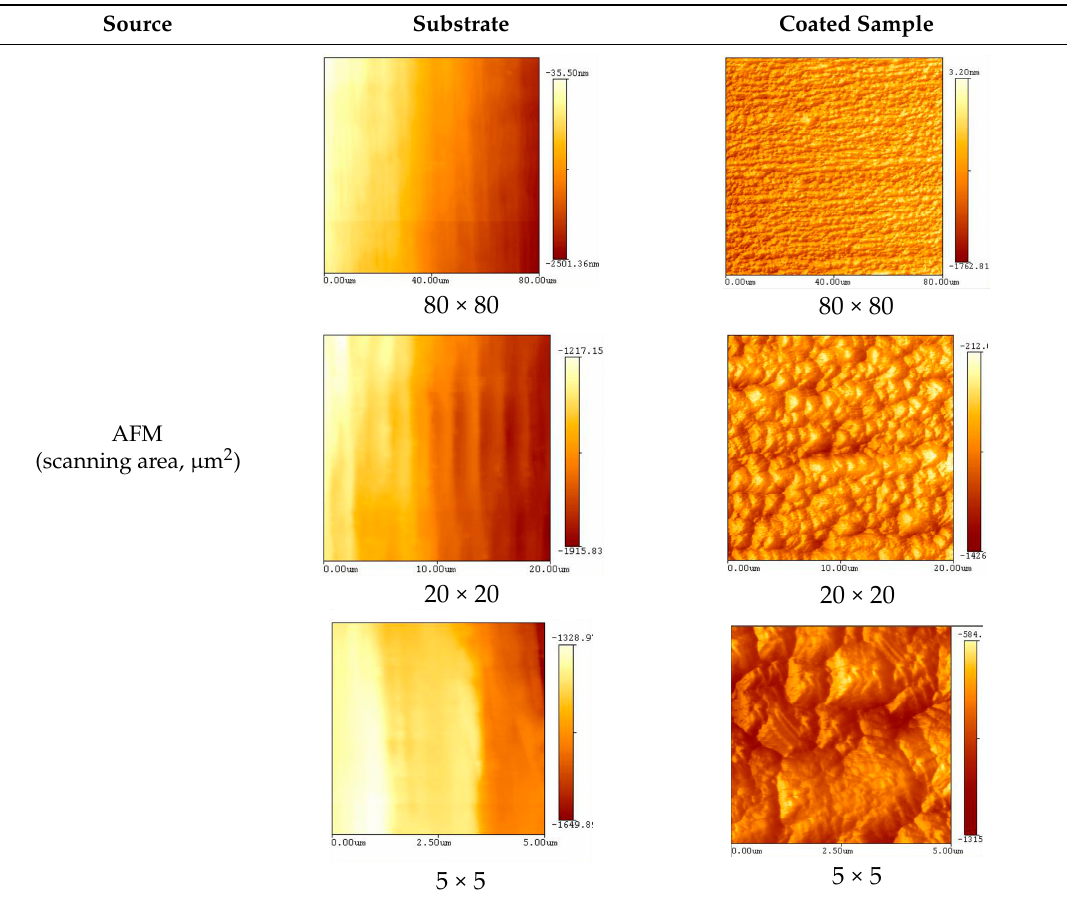
section preparation and its etching; ( b ) after electrolysis.